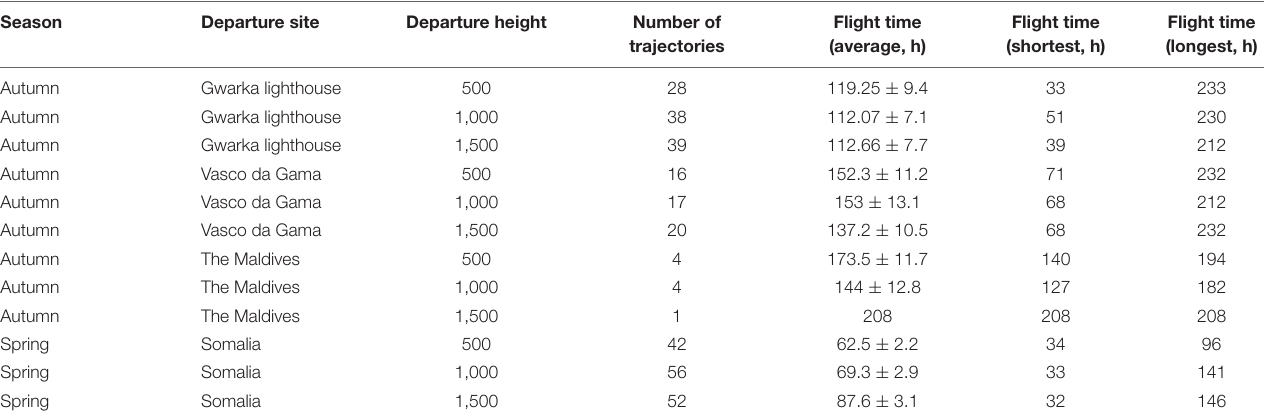
TABLE 2 | Successful autumn and spring simulated migrations events from the wind trajectory